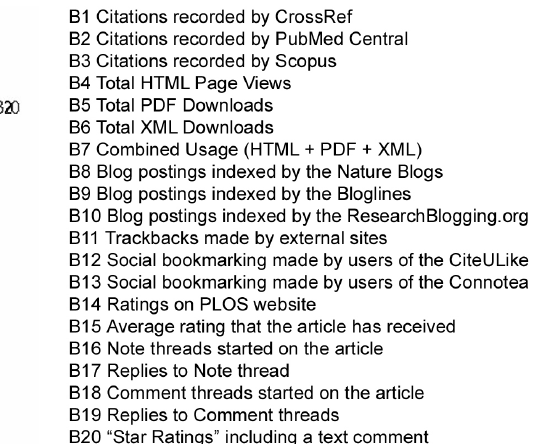
Figure 4. Social network structure diagram of altmetric